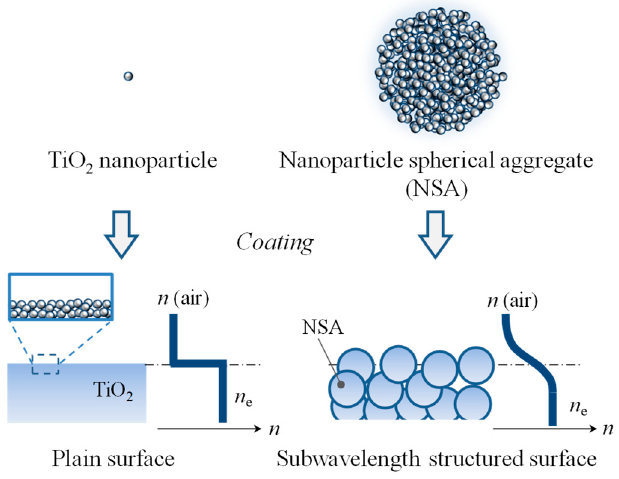
Figure 1. Illustration of a graded refractive index at the air–TiO 2 interface using a spherical nanoparticle aggregate (NSA) film.